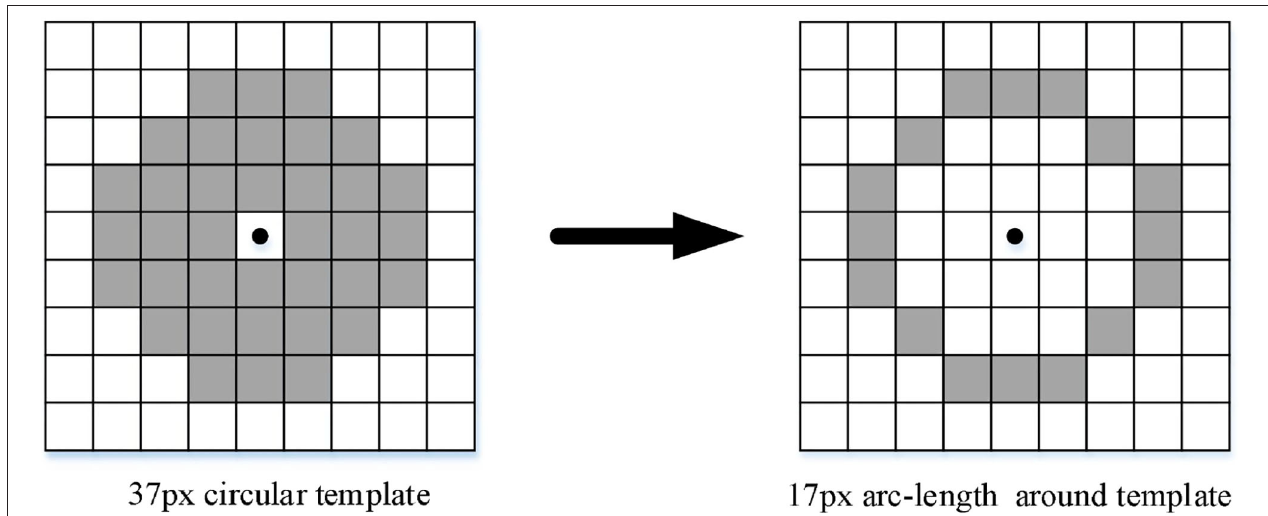
FIGURE 5 | Circular template transform as arc–length